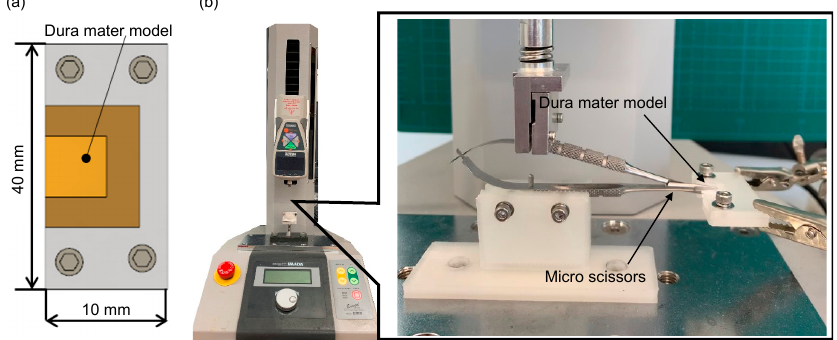
Figure 10. Experimental setup of the microscissors test in dura-matter models: ( a ) Design of fixture of dura-mater models; ( b ) Photographs of experimental setup for the microscissors